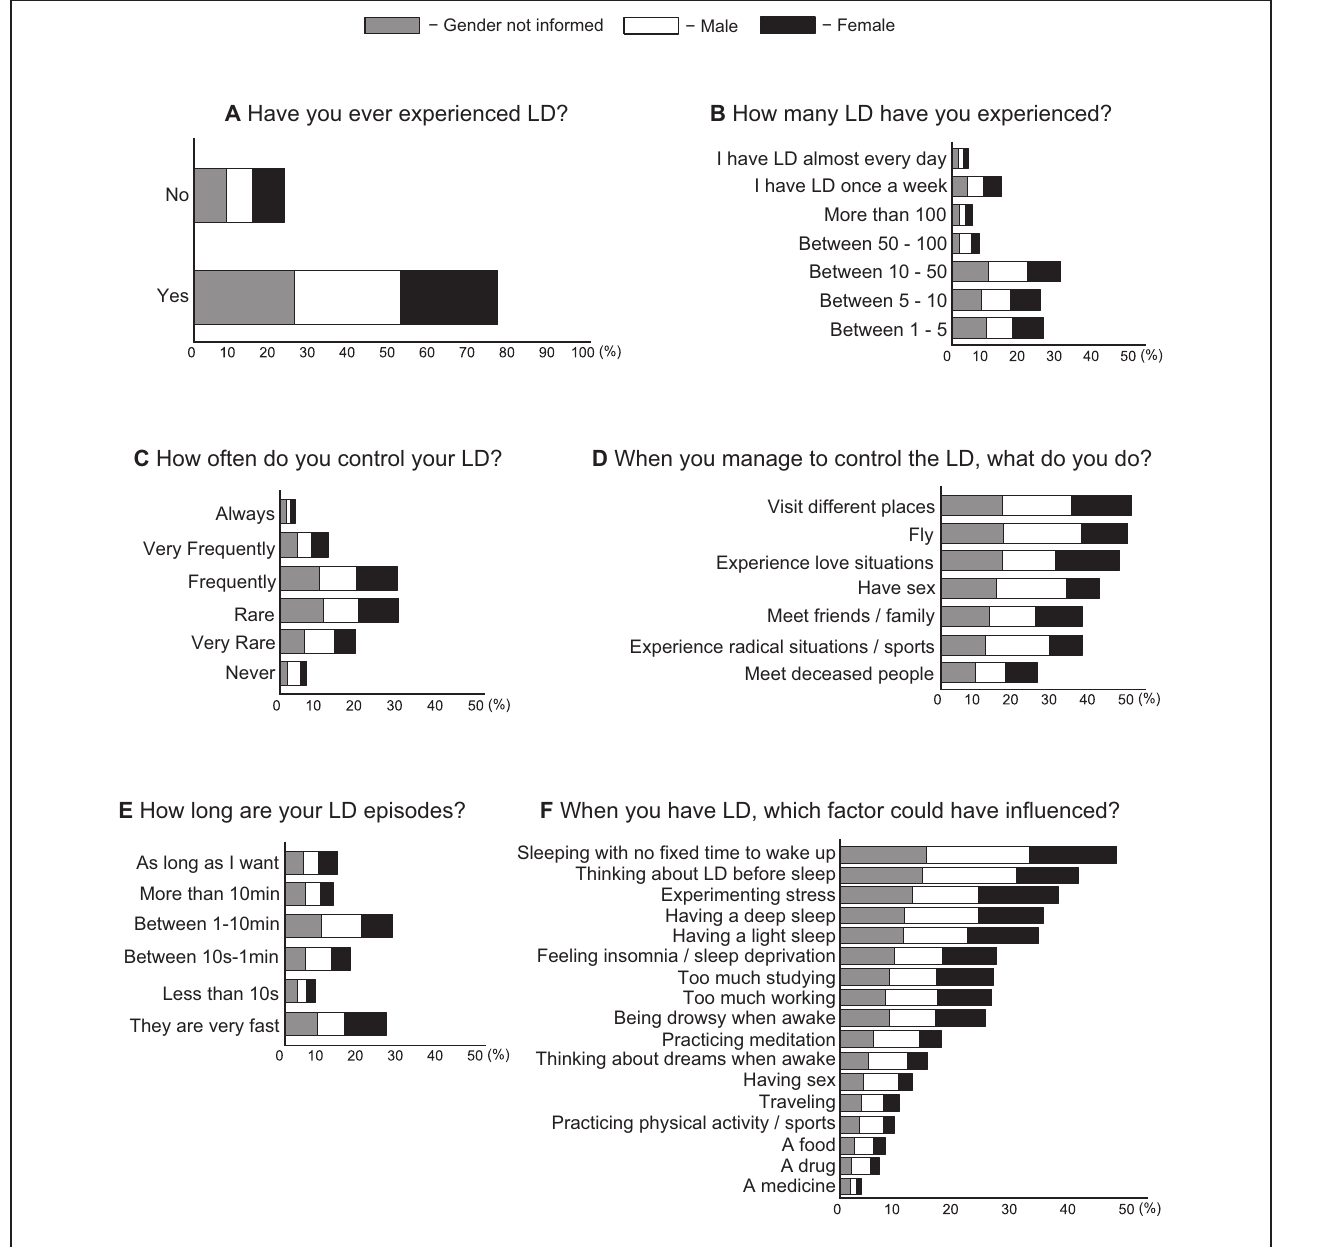
FIGURE 3 | Frequency and content of LD for female (black), male (white), gender not answered (gray). ( A ) Percentage of LD report for at least once in lifetime. ( B ) Number of LD episodes recall. ( C )